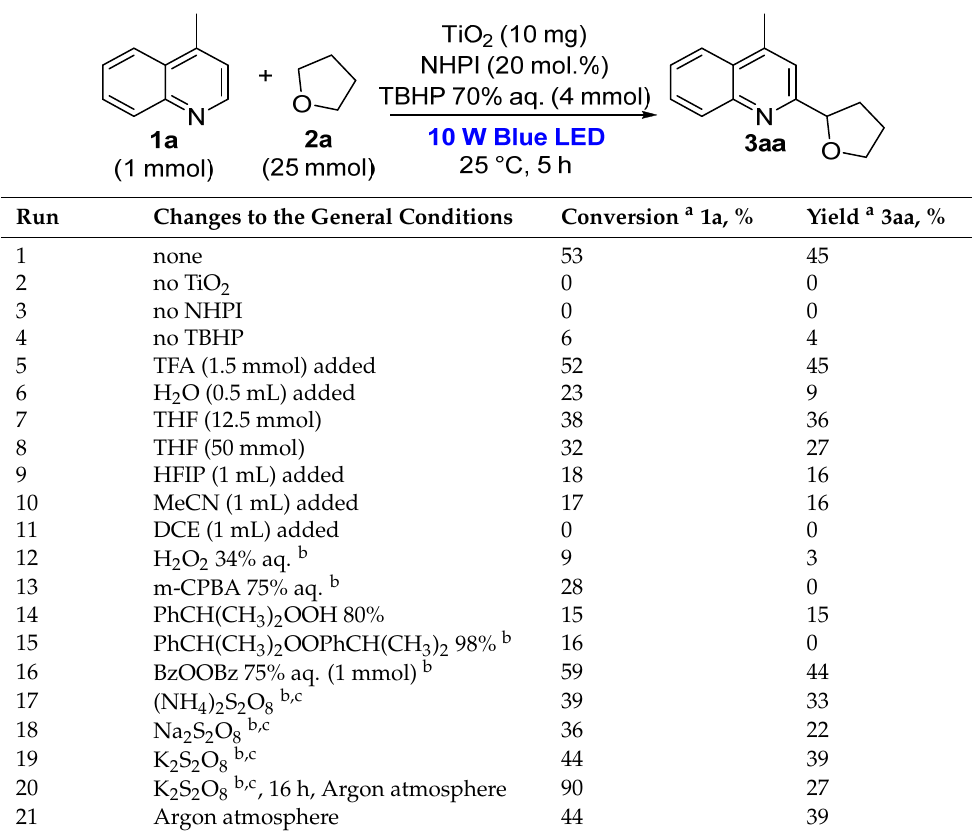
Table 1. Influence of photocatalytic system composition, irradiation power, and nature of oxidant on the conversion of 4-methylquinoline 1a and yield of 3aa in photocatalytic Minisci reaction.